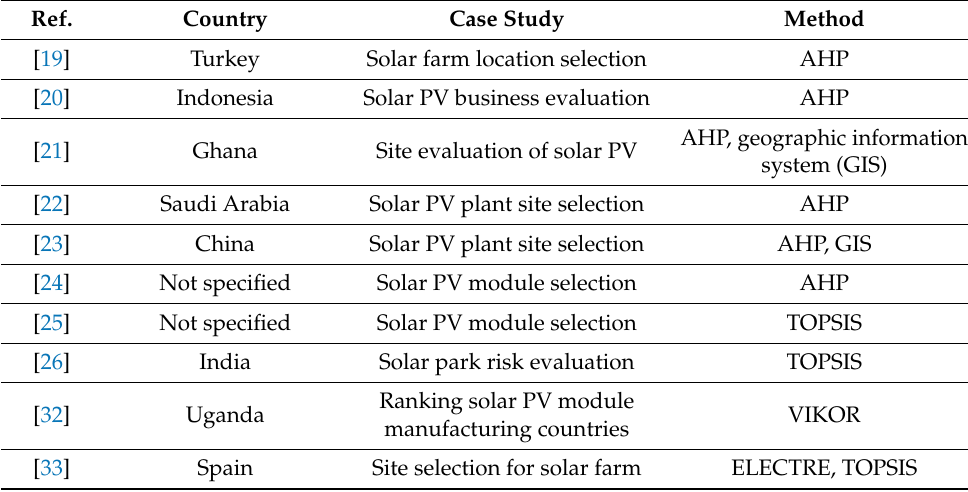
Table 2. Summary of the search on the solar PV module selection using MCDM methods.